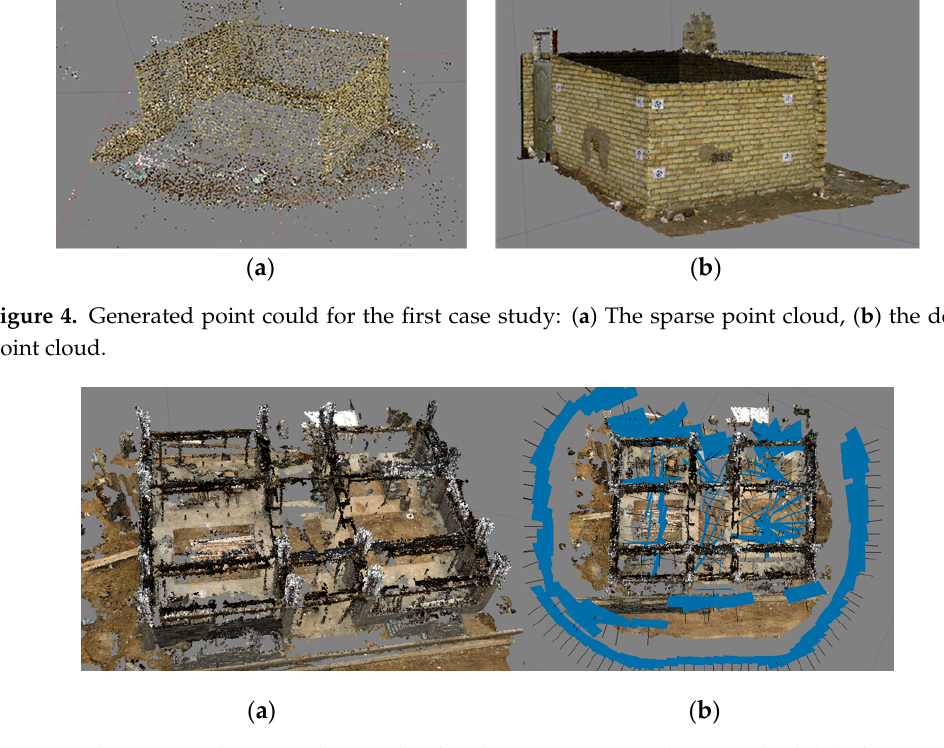
Figure 5. The improved generated point cloud and camera positions (Case study 2): ( a ) The improved generated point cloud ( b ) the camera positions (The images where captured from every 15 degrees.).